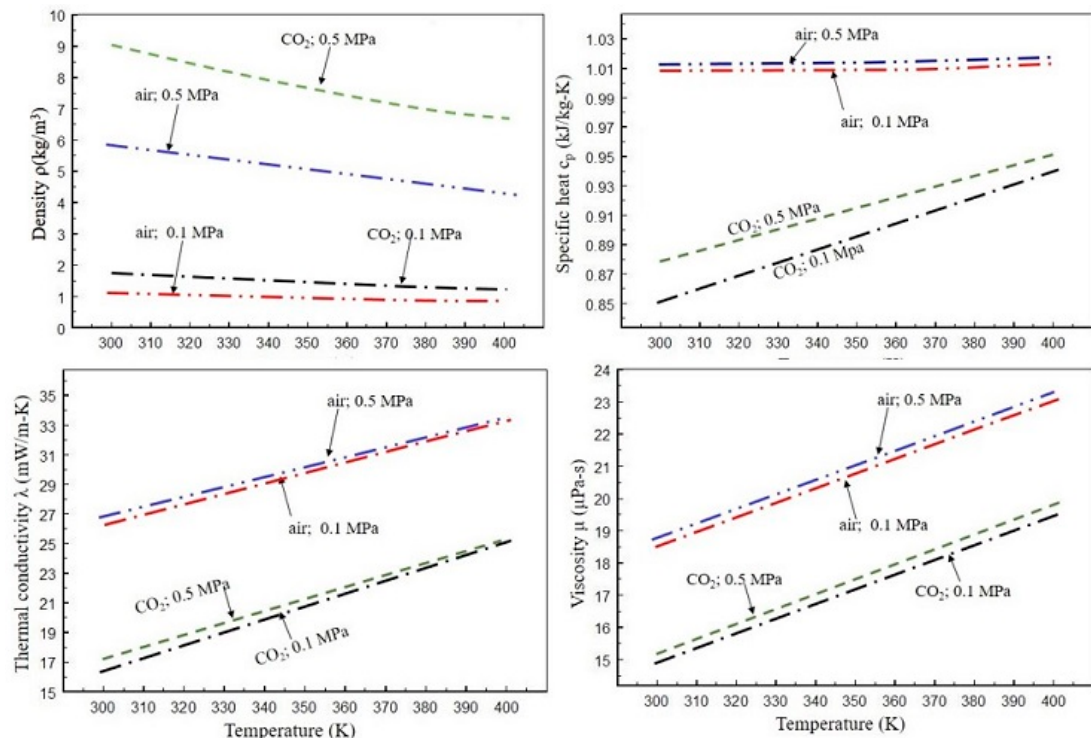
Figure 1. Thermophysical properties of gaseous CO 2 and air for pressures from 0.1 to 0.5 MPa and temperature from 300 to 400 K.